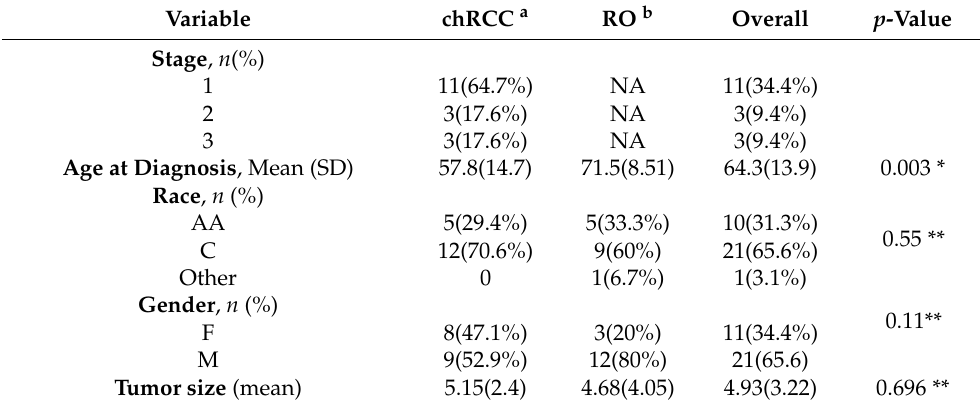
Table 1. Clinical and Demographic information for chRCC and RO cases in the AUMC cohort.